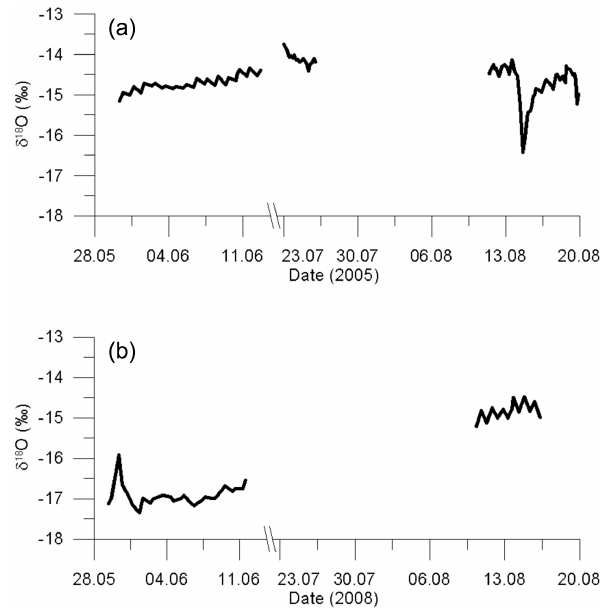
Figure 2. δ 18 O time series of meltwater draining Mittivakkat Gletscher in (a) 2005 and (b)